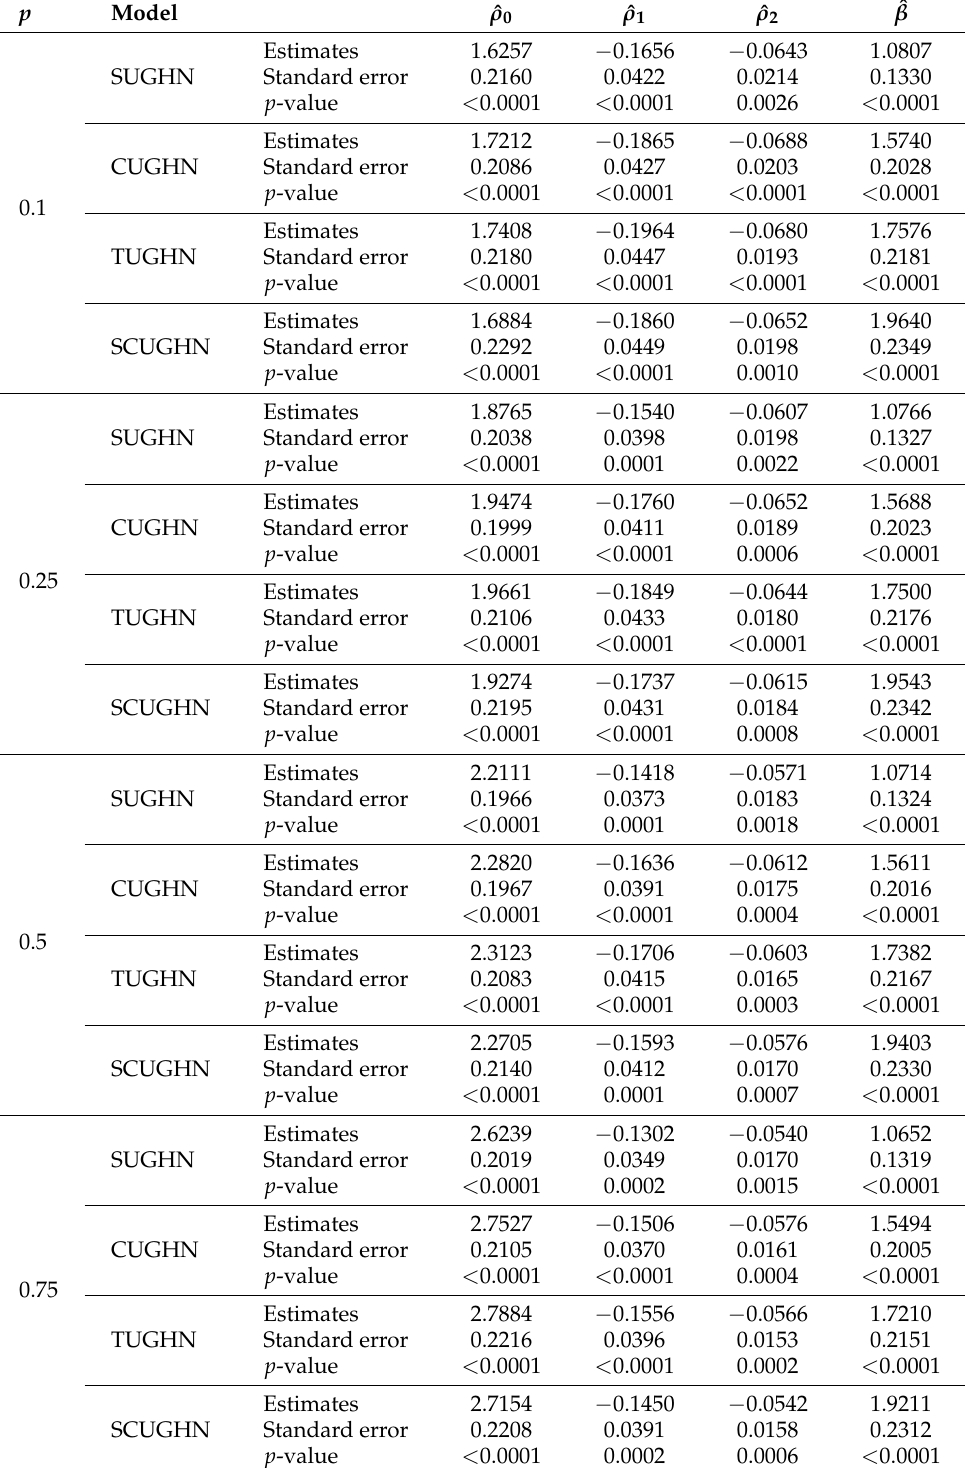
Table 3. Estimates of parameters, standard errors, and p -values for some